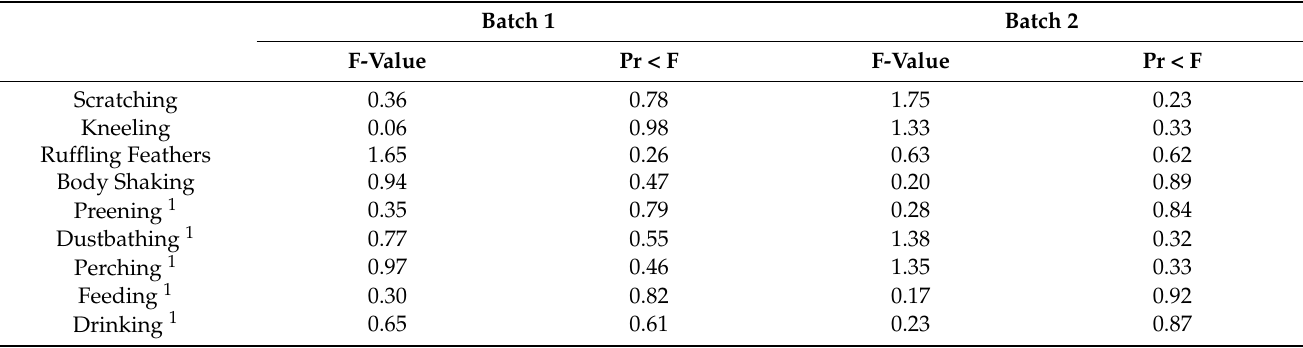
Table 3. F test for treatment effect on behavior counts in laying